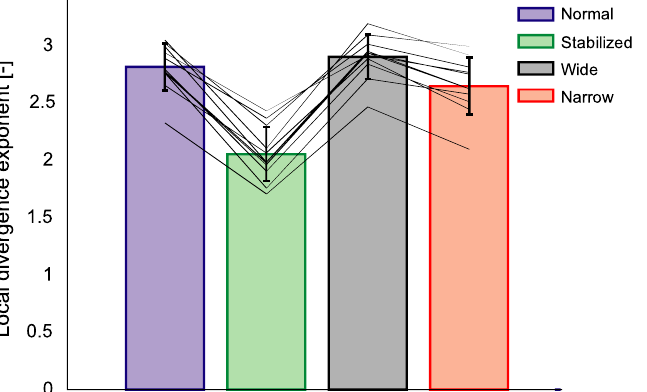
Figure 3. Local divergence exponents during normal walking (blue), walking with external stabilization (green), wide-base walking (black) and narrow-base walking (red). Mean values (bars), standard deviation (error bar) and participants’ individual changes across conditions (lines) for the evaluated conditions.